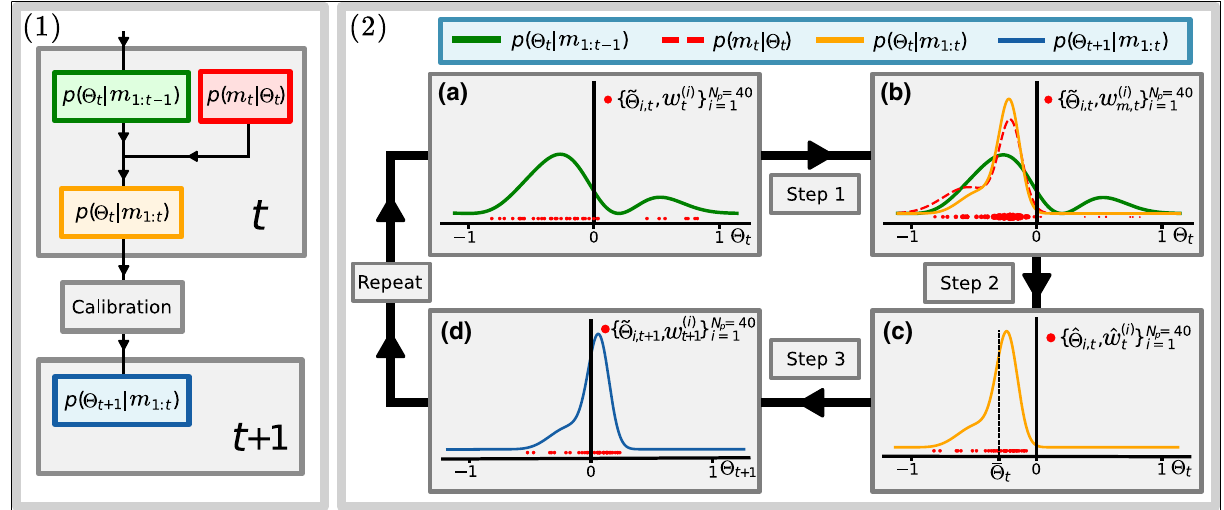
FIG. 3. (1) Representation of a cycle of the calibration process. The initial probability distribution at iteration t with t − 1 measure- ments, p ( (cid:2) t | m 1: t − 1 ) , is updated by performing a new set of measurements, m t , to obtain p ( (cid:2) t | m 1: t ) . The estimates obtained from this probability distribution can then be used to calibrate the parameters, obtaining the initial probability distribution for iteration t + 1. (2) Steps followed to perform an iteration of the particle filtering algorithm for a simplified case with only one parameter, (cid:16) . In (a) } (red dots) from the prior probability distribution p ((cid:16) | m ) (green). A new set of measurements is we have particles { (cid:9) (cid:16) i , t , w ( i ) 1: t − 1 t t performed to obtain the posterior probability distribution p ((cid:16) t | m 1: t ) (orange) in (b) by using the likelihood of the outcome obtained for the measurement, p ( m t | (cid:16) t ) (red). The weights are updated following Eq. (23), where a larger weight is visually represented by a larger size of the particle. These weighted particles can be used to obtain the estimate of the parameter at this iteration, ¯ (cid:16) t , by using Eq. (24). In (c), a resampling process is performed to obtain particles with equal weights that approximate particles from the posterior probability distribution. The previously obtained value ¯ (cid:16) t is also shown here. Finally, in (d), ¯ (cid:16) t has been used to calibrate the param- eter (cid:16) , where for this example, we are assuming that the ideal value of (cid:16) is zero; therefore, the correction applied is to change the value of the parameter by − ¯ (cid:16) t . The probability distribution p ((cid:16) t + 1 | m 1: t ) (blue) consequently has an estimate of